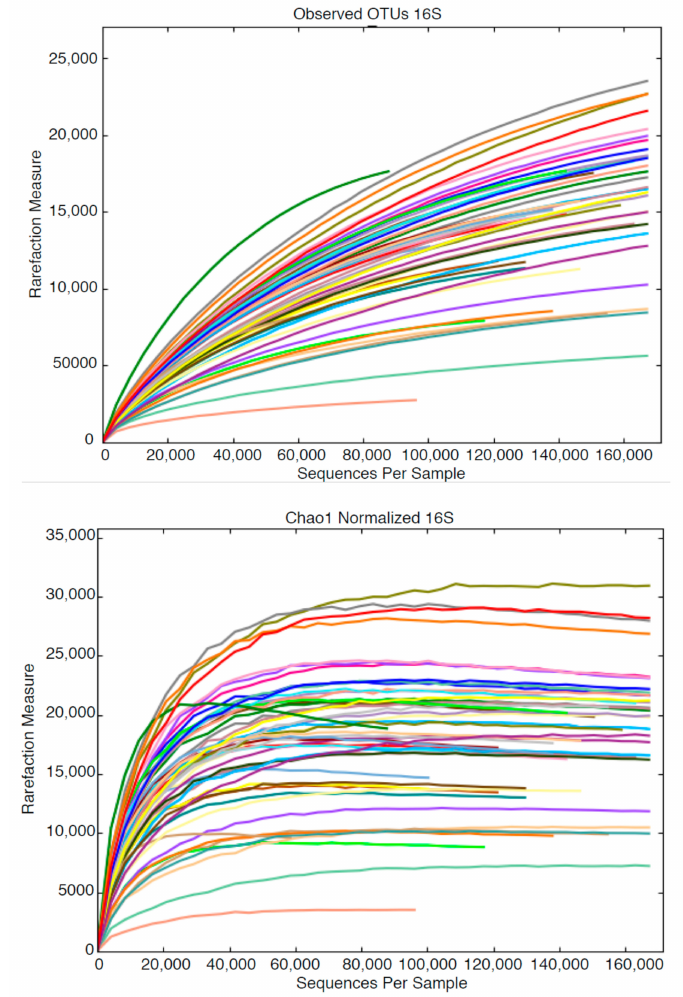
Figure 1. Rarefaction curves showing the relationship between sequences per sample and Operational Taxonomic Unit (OTU) resolution. In the lower graph, samples are categorized by